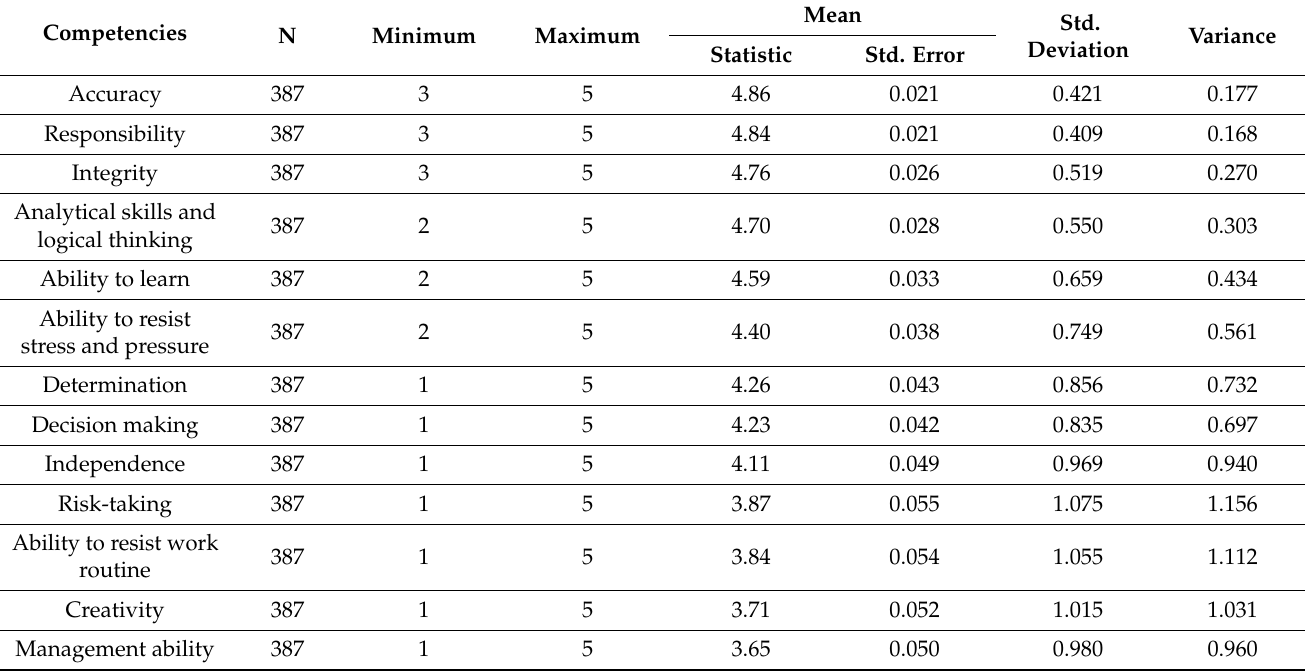
Table 3. Ranking of Personal